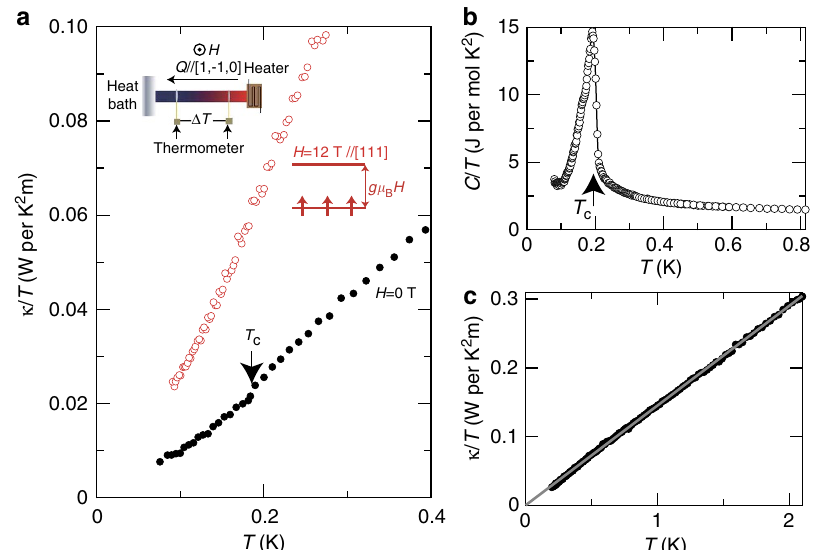
Figure 2 | Low-temperature thermal conductivity and specific heat of Yb 2 Ti 2 O 7 . ( a ) k / T at zero and m 0 H ¼ 12Tapplied along [1, 1, 1] direction is plotted against temperature. The heat current is applied along [1, (cid:3) 1, 0]. At T C , k / T exhibits a jump, indicated by an arrow. Inset illustrates the measurement configuration of the thermal conductivity. ( b ) Specific heat divided by temperature C / T at zero field. ( c ) k / T at zero field in the spin-liquid state above 0.2K. Grey line is a fit to a T -linear dependence k / T ¼ AT with A ¼ 0.15W per K 2